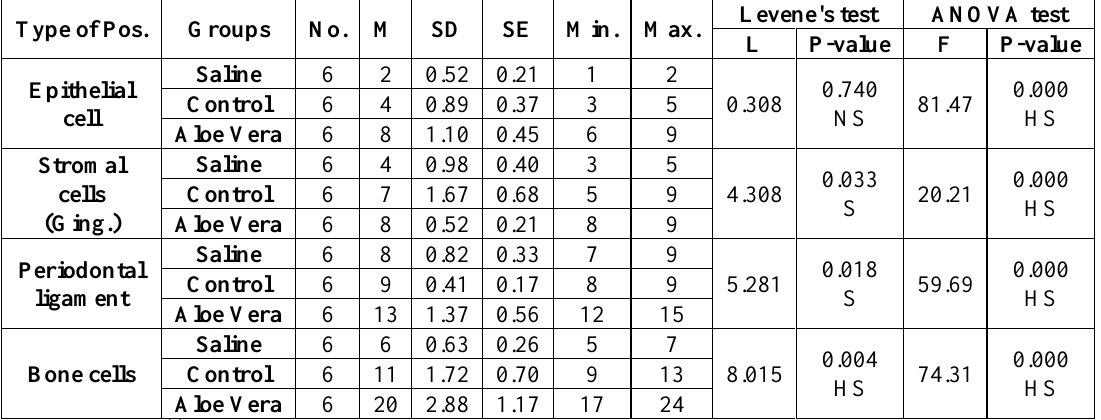
Table1: Statistic analysis of positive expressed cells for syndecan 1 in the studied groups with comparisons significant Type of Pos. Groups No. M SD SE Min. Epithelial Stromal cells (Ging.) Saline Periodontal ligament Bone cells